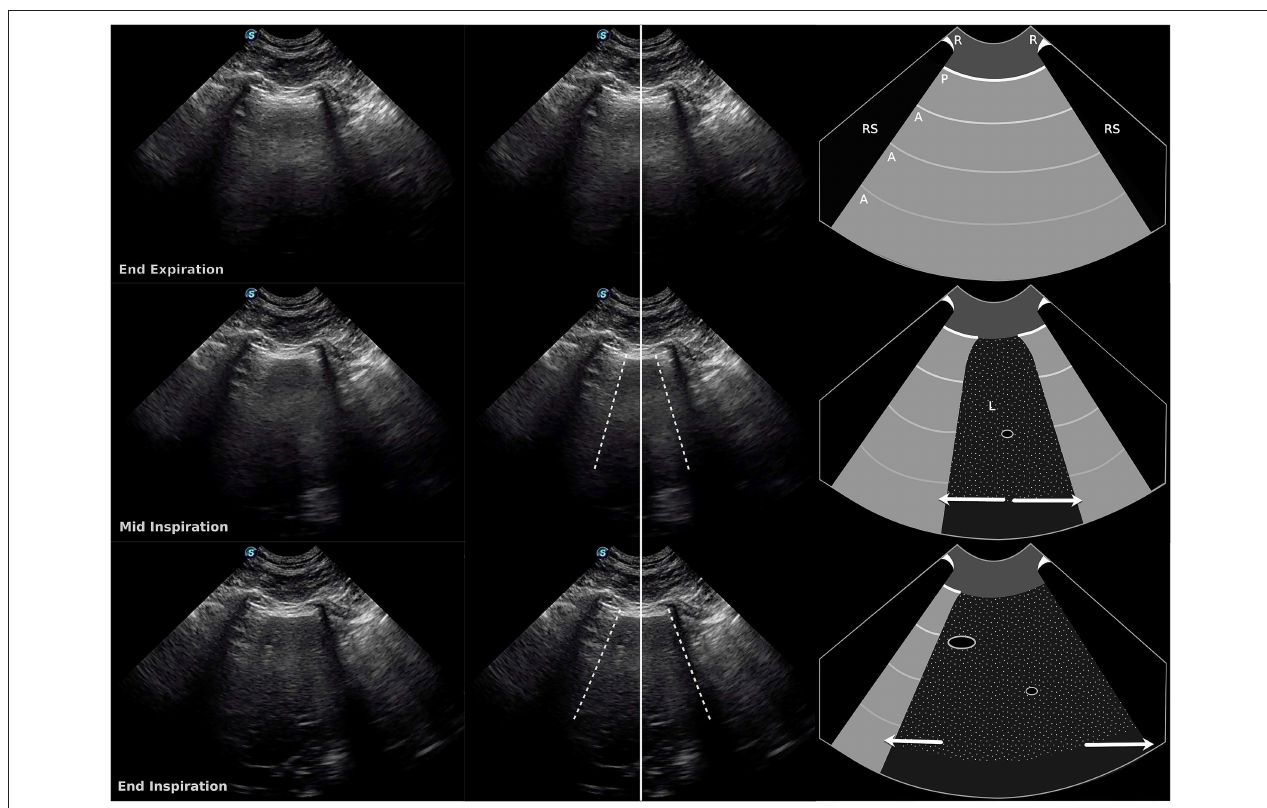
FIGURE 3 | Still images and schematic of a double curtain sign at end expiration (top row), mid-inspiration (middle row), and end inspiration (bottom row). The ultrasound probe is located over the liver, about halfway up the thorax, between the 7th and 8th intercostal spaces, over the air/soft tissue interface between the abdomen and the thorax. During inspiration, two vertical edges of the curtain sign are visible in the same sonographic window. Dashed lines, vertical edges (air/soft tissue interface); Solid line, center of image; R, rib; RS, rib shadow; P, pleural line; A, A line; L, liver. Arrows show movement of the vertical edges in opposite directions during inspiration in this example. Length of arrow represents degree of movement relative to the image above (also see Video S3 ).